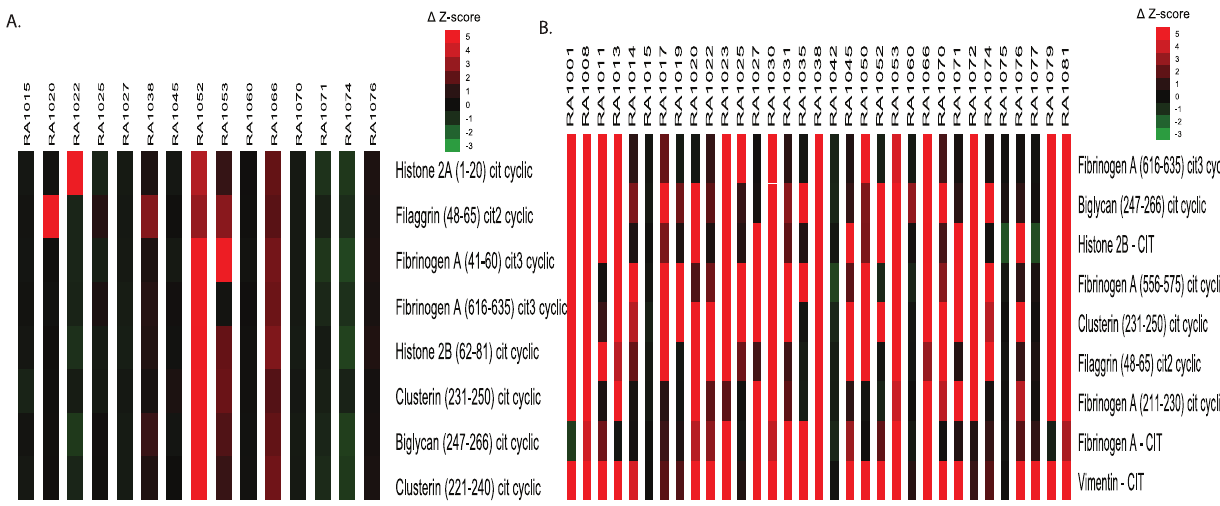
Figure 2. Accumulation of ACPA fine specificity before and concurrent with anti-CCP2 antibody seroconversion. A, Paired SAM analysis was performed on serum specimens from pre-clinical RA patients from whom at least 2 specimens were available prior to anti-CCP2 antibody seroconversion. B, Paired SAM analysis was performed on serum specimens from pre-clinical RA patients for whom a serum specimen was available both prior to and after anti-CCP2 antibody seroconversion. The heatmap represents absolute change in Z-score* from the first to the second timepoint. *Z-score represents the number of standard deviations above or the below the mean level observed in control subjects for each cytokine or autoantibody thus increase in Z-score represents increased change from normal population.